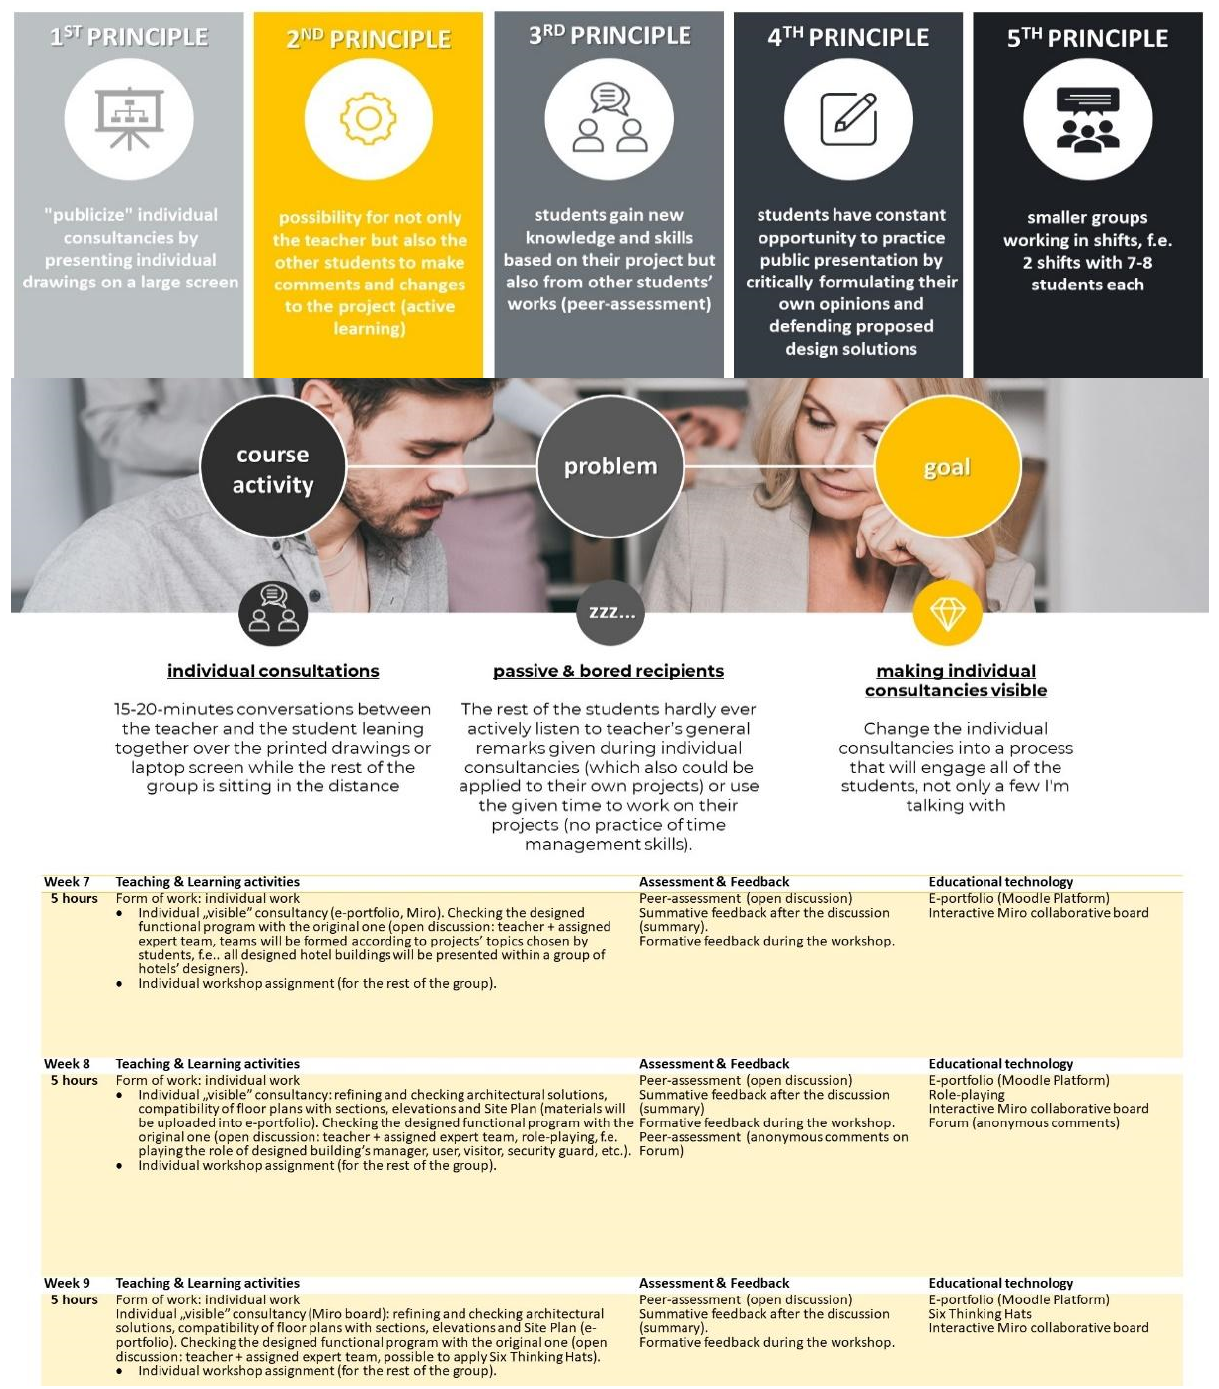
Figure 2. Educational Innovative Project “Individual consultations. Make them visible!” planned during the international Masters of Didactics program and introduced in VDS courses during spring semester 2019/2020 and winter semester